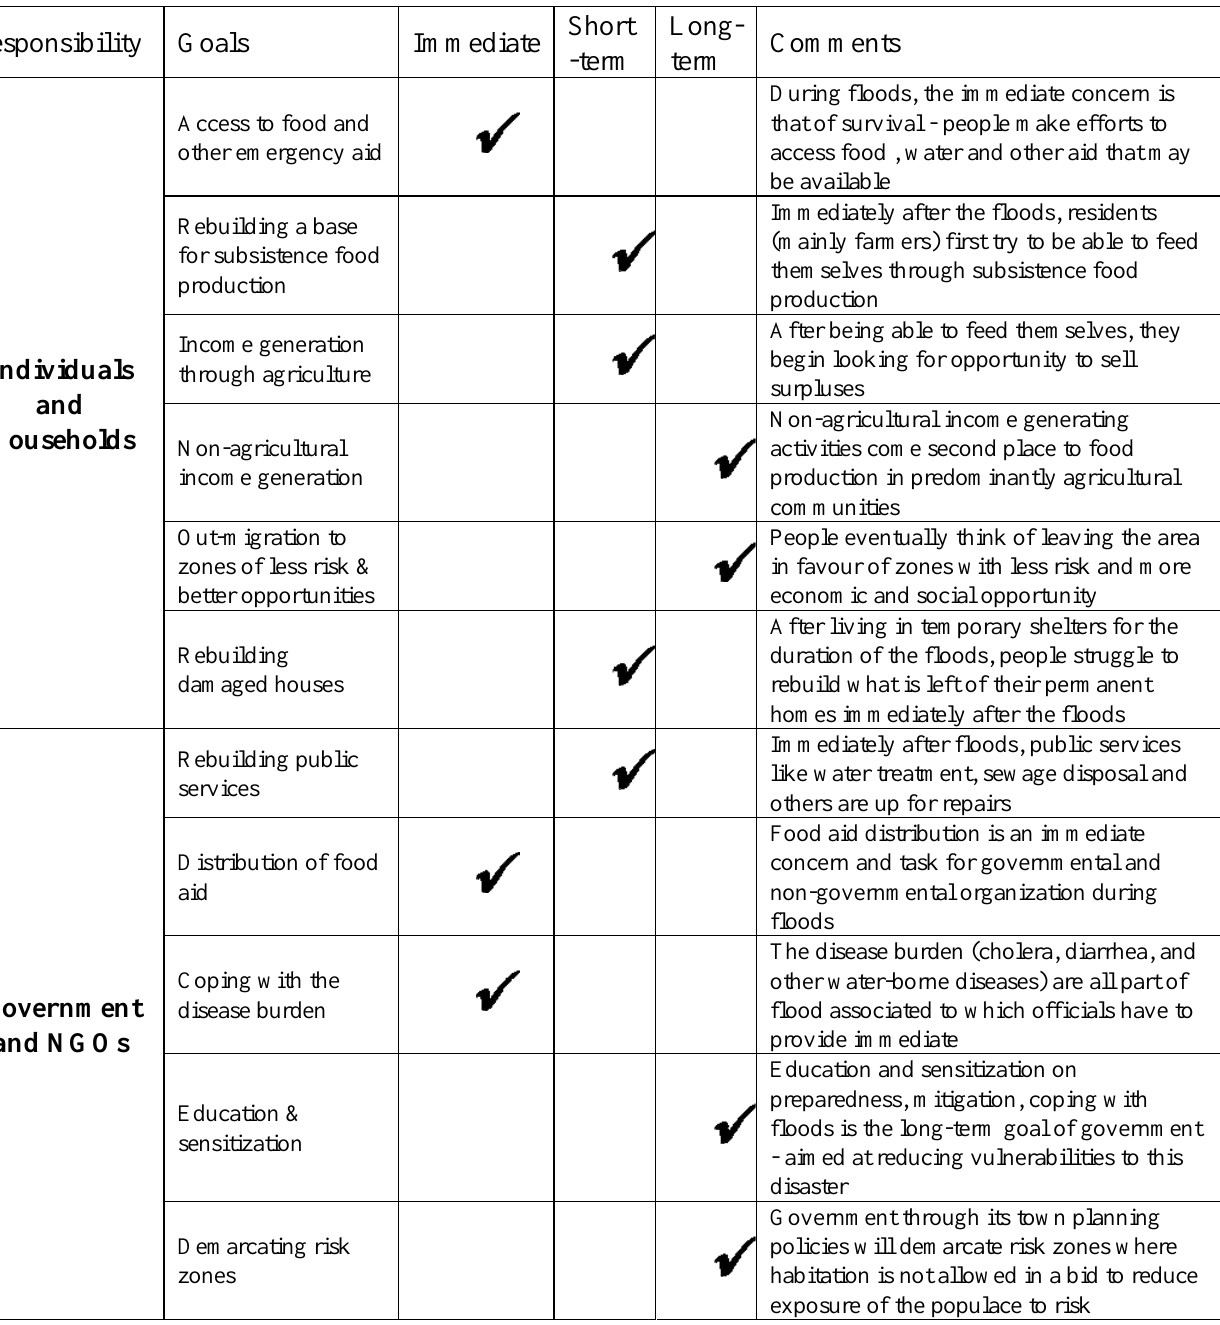
Table 3. Timelines for the implementation of flood coping mechanisms in the study area by individuals and families, governmental and non-governmental